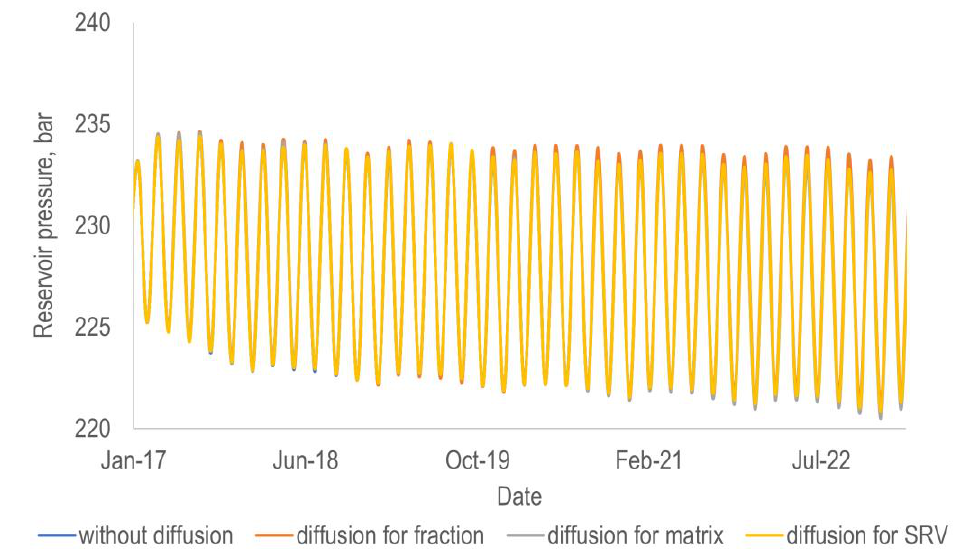
Figure 13. Average reservoir pressure for diffusion coefficients for the fracture zones, SRV, matrix, and without diffusion.